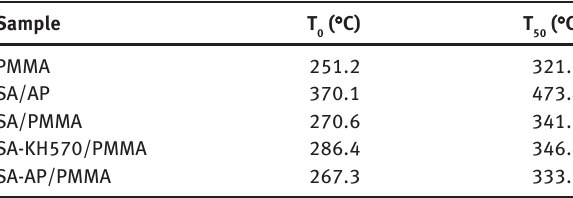
Table 2: TGA data of poly(methyl methacrylate) (PMMA) and